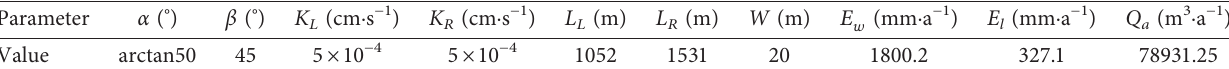
Table 2: Calculation parameters.